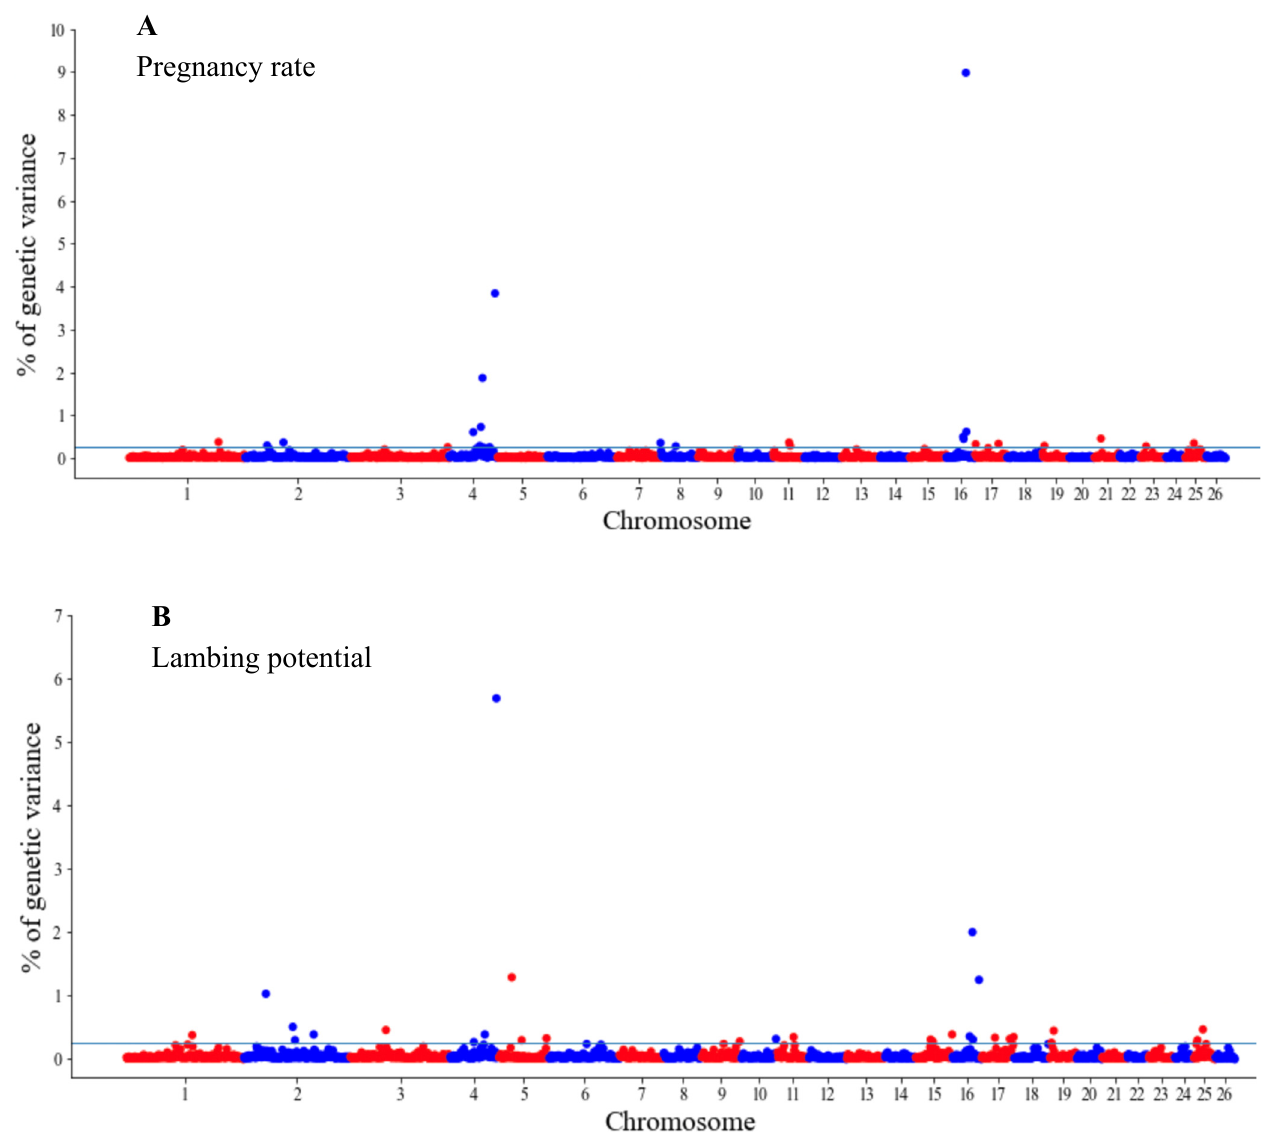
Figure 3. Manhattan plots of genetic variance explained (%) by 20 adjacent SNP windows for the pregnancy rate ( A ) and lambing potential ( B ). Each dot represents a window. The % of additive genetic variance explained by each window and chromosomes 1–26 are shown on the Y -axis and X -axis, respectively. The horizontal line indicates the suggestive threshold of 0.25% of the PVE.